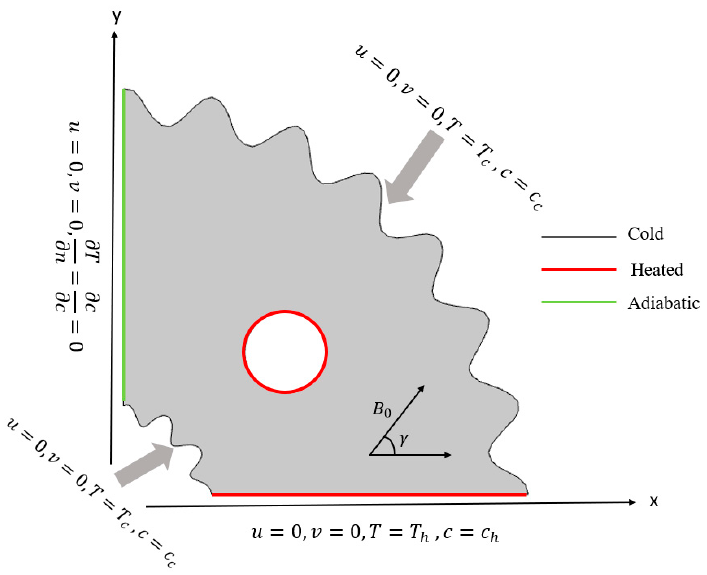
Figure 1. Graphical visualization of the domain.